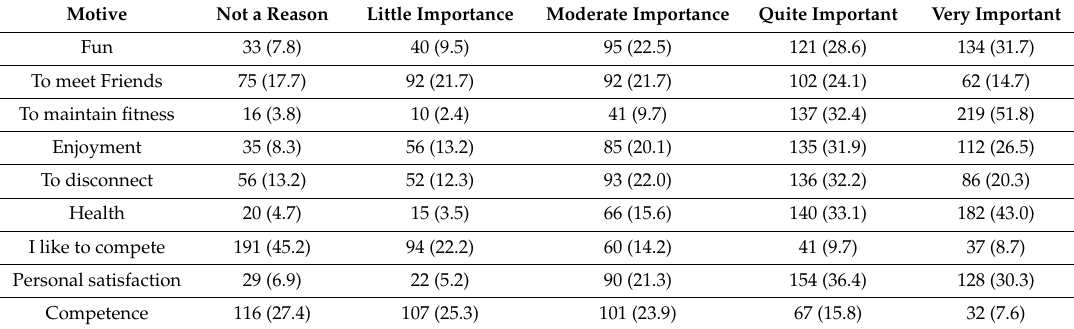
Table 3. Categorisation of the reasons to undertake